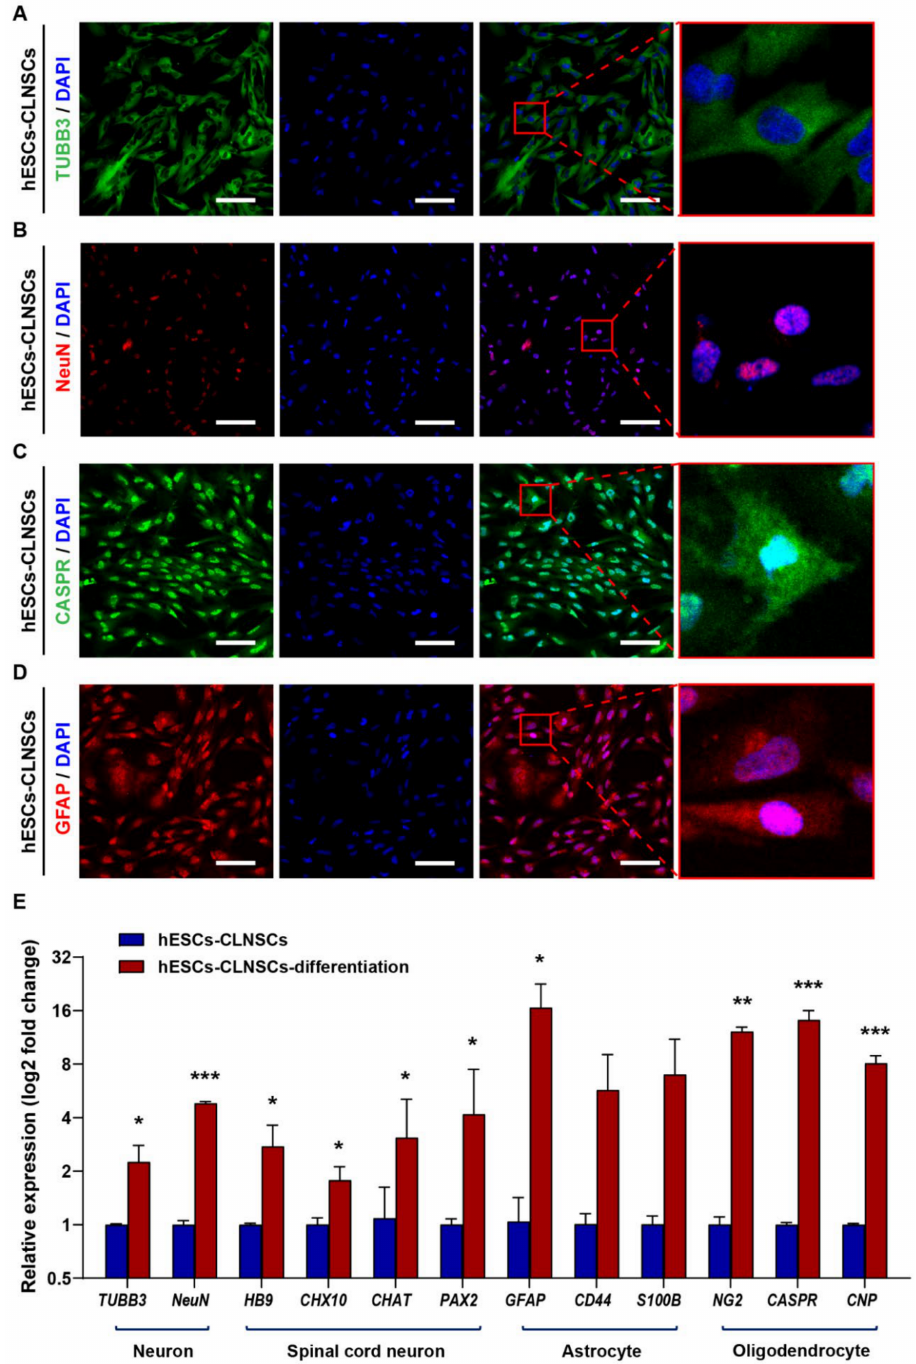
Figure 3. The hESCs-derived CLNSCs differentiated to neurons, astrocytes, and oligodendrocytes. ( A ) Specific immunos- taining for neuronal marker TUBB3 (green) was confined into the cytoplasm, scale bar: 100 µ m. Right picture shows a magnification of the merge at a ratio of 1:50. ( B ) Specific immunostaining of neuronal nuclei marker NeuN (red), scale bar: 100 µ m; right picture shows a magnification of the merge at a ratio of 1:50. ( C ) Immunostaining for oligodendrocyte marker CASPR (green), scale bar: 100 µ m. Right picture shows a magnification of the merge at a ratio of 1:50. ( D ) Immunostaining for astrocytic marker GFAP (red), scale bar: 100 µ m. Right picture shows a magnification of the merge at a ratio of 1:50. ( E ) qRT-PCR analysis of neural gene expression in hESCs-CLNSCs and their differentiated cells (Passage 28) after 12 days of induction of differentiation. Data represent mean values of 3 independent experiments. Error bars indicate SD, significant differences were determined using Student’s t -test; * p < 0.05; ** p < 0.01; *** p < 0.001 for indicated